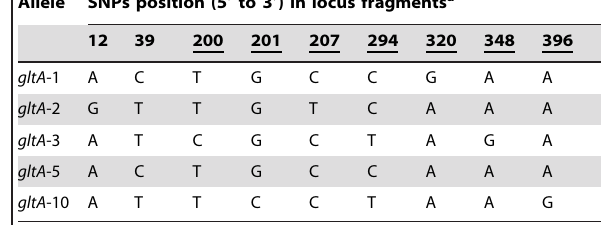
Table 3. SNPs in gltA locus fragments.